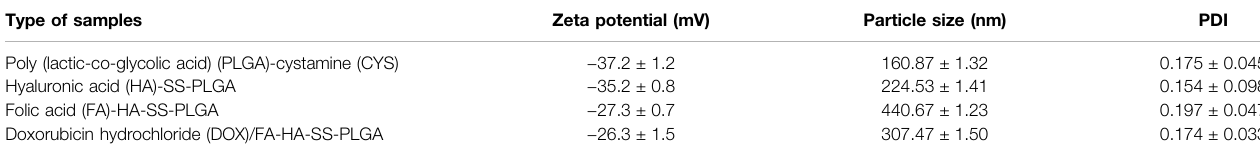
TABLE 1 | Physical and chemical properties of micelles ( n = 3, (cid:1) x ± SEM). Type of